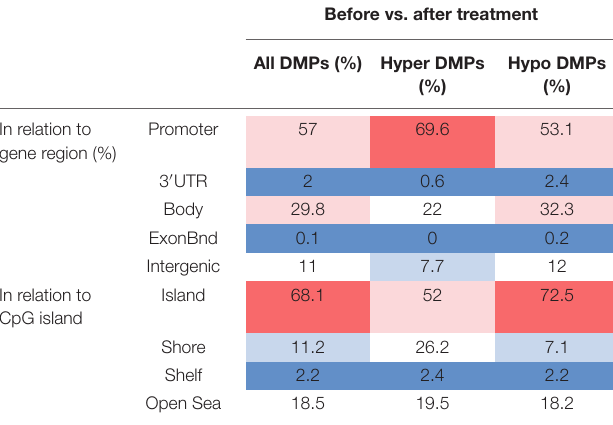
TABLE 4 | Functional genomic distribution of DMPs in CD8 + T cells in response to treatment.